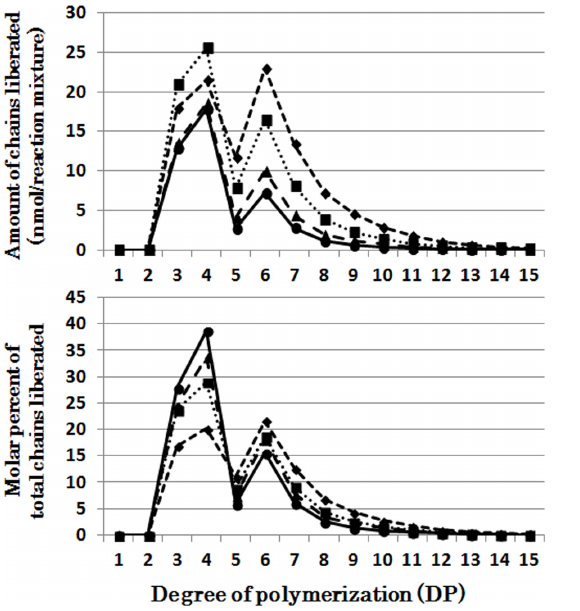
Fig 4. Chain-length preference of Cyanothece ATCC 51142 isoamylase (CytISA) in debranching phytoglycogen. Upper panel shows the amount of chains liberated after enzymatic reaction with CytISA and phytoglycogen for 5 ( ● ), 10 ( ▲ ), 30 ( ■ ), and 60 ( ♦ ) min, respectively. Lower panel shows the molar percentage of each liberated chain to the total liberated chains.